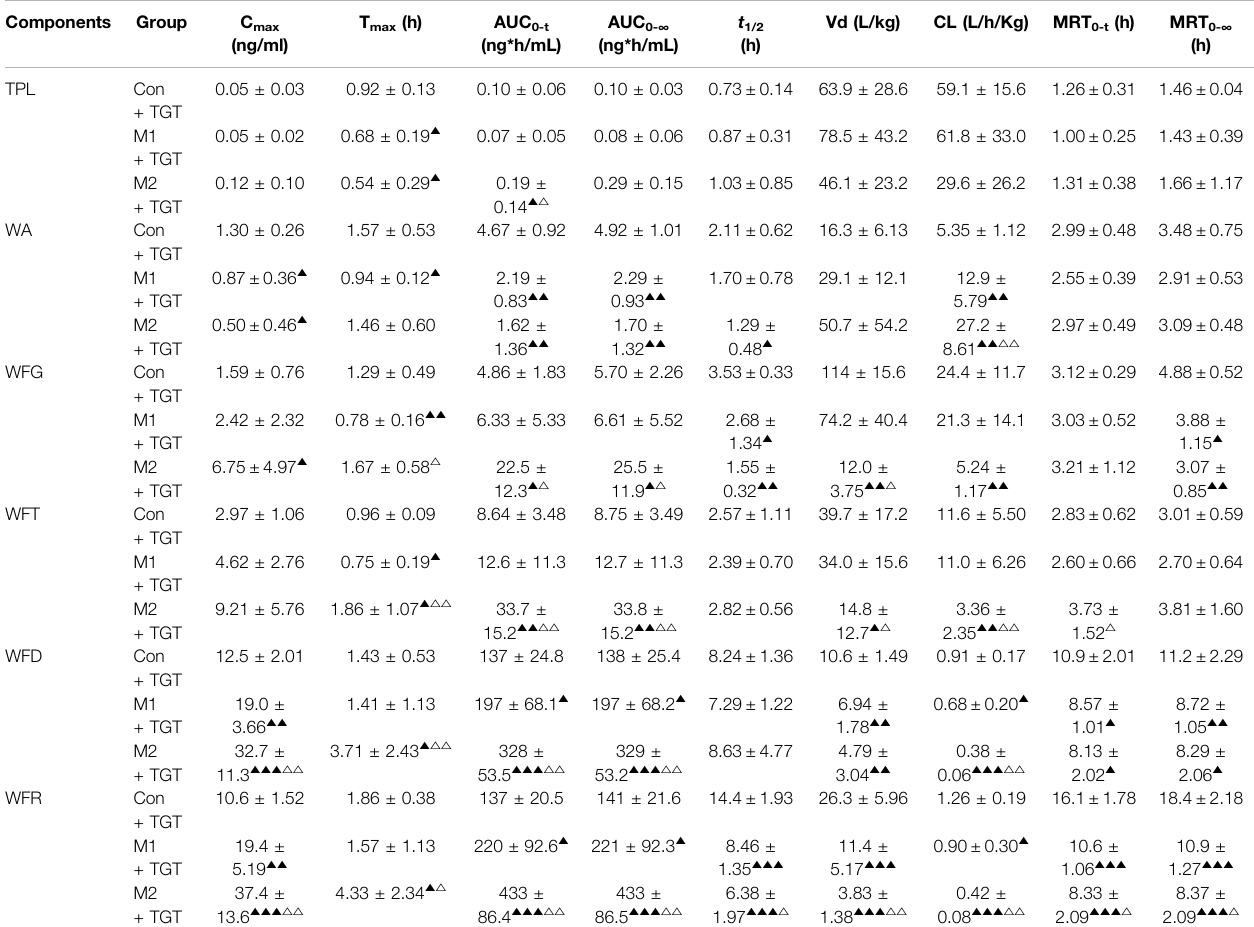
TABLE 1 | Pharmacokinetic parameters of the six key TGT components in the normal and two types of adriamycin-induced-NS rats after a single TGT oral gavage dose of 10 mg/kg ( n = 7).